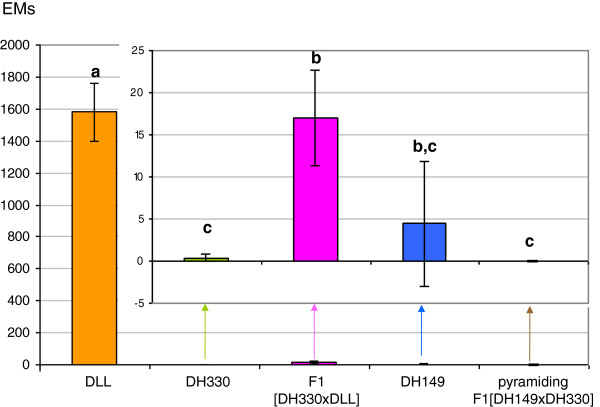
Comparison of mean number of egg-masses (EMs) on peppers maintained in climate controlled room after inoculation with 5000 avirulent M. incognita juveniles (mean of 70 to 100 replicates ± standard error). DLL was the susceptible cultivar as control, DH149 is homozygous resistant Me3/Me3, DH330 is homozygous resistant Me1/Me1. Modalities with different letters display significant differences at P = 0.05.